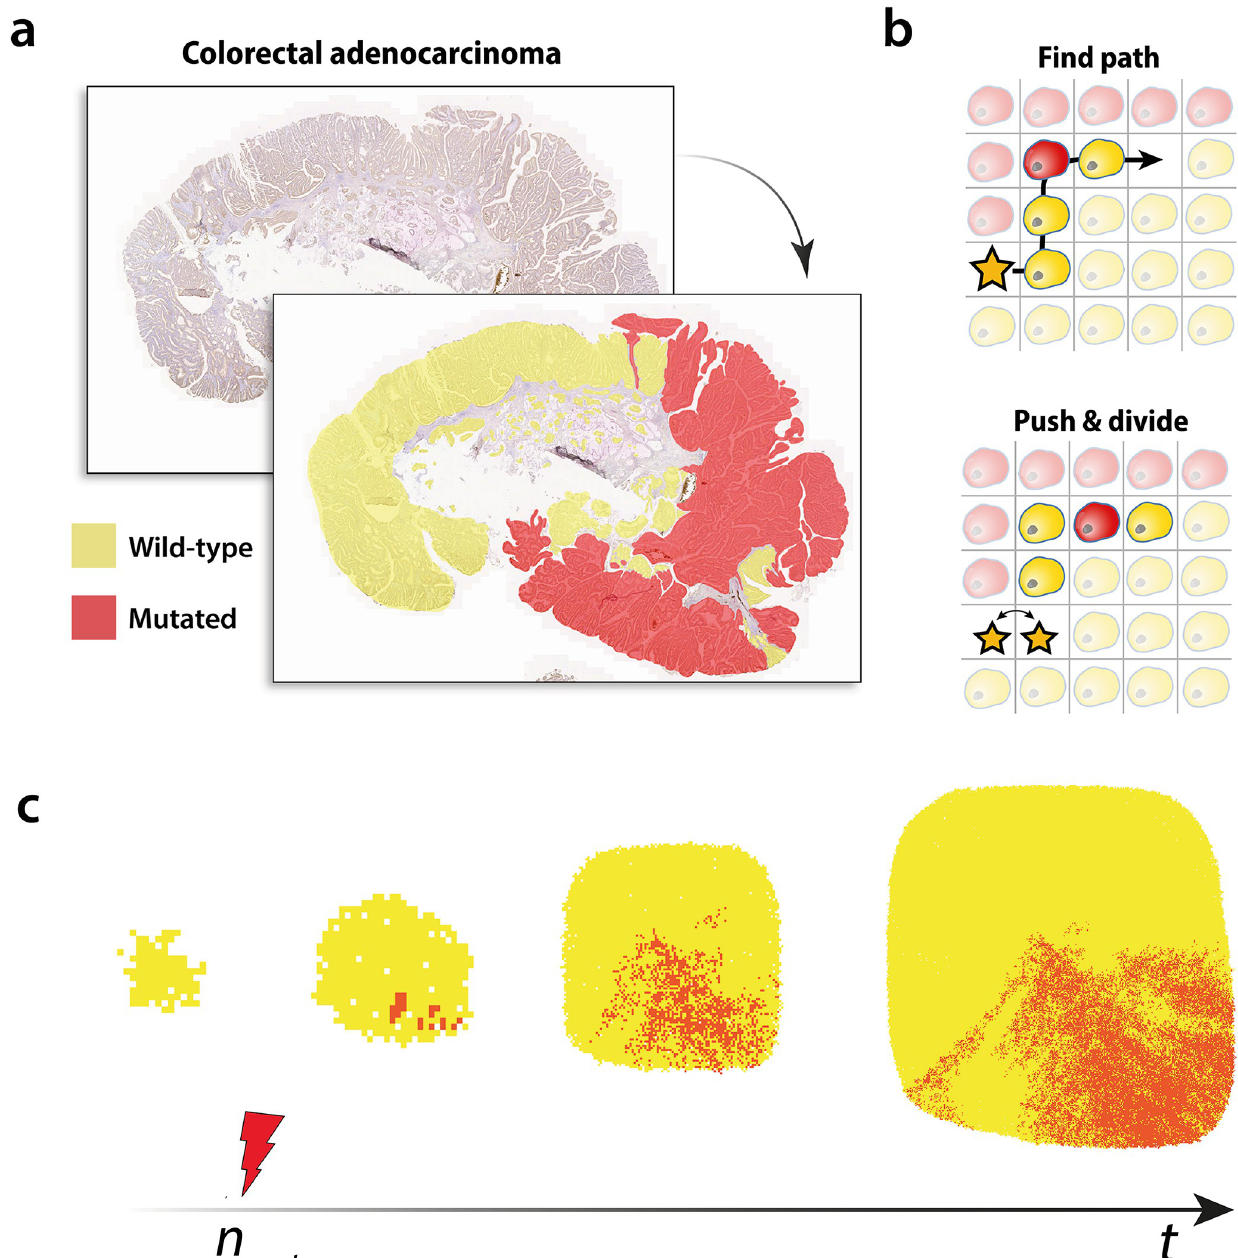
Fig 1. Sub-clonal mixing in human colorectal tumours. (a) Sub-clonal mixing patterns in human colorectal adenocarcinoma tissue revealed with BaseScope. Tumour cells carrying the KRAS G12A mutation are highlighted in red. Those which are wild-type at this loci are highlighted in yellow. (b) Cell pushing in spatial simulations. A dividing cell (star) creates the space needed to divide into two cells by pushing neighbouring cells along a path to a nearby empty lattice point. (c) Computational model of tumour sub-clonal mixing. Competing wild-type (yellow) and mutated (red) cell populations clonally expand on a 2-dimensional square